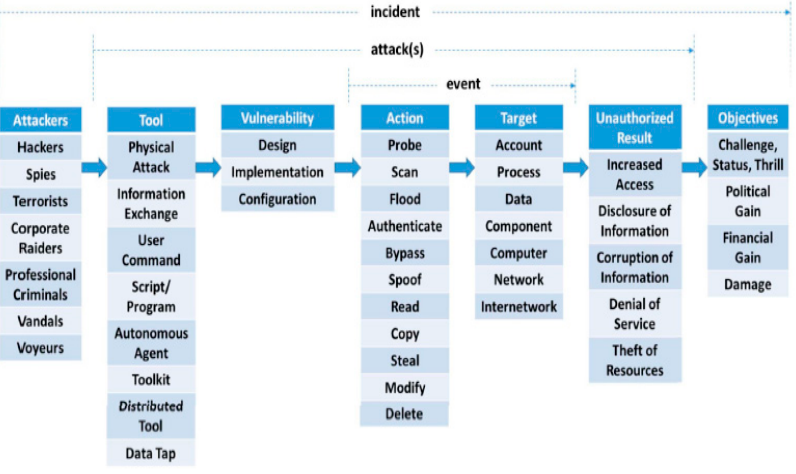
Figure 11. Modified attack taxonomy for Power System threatening the charging network [67].